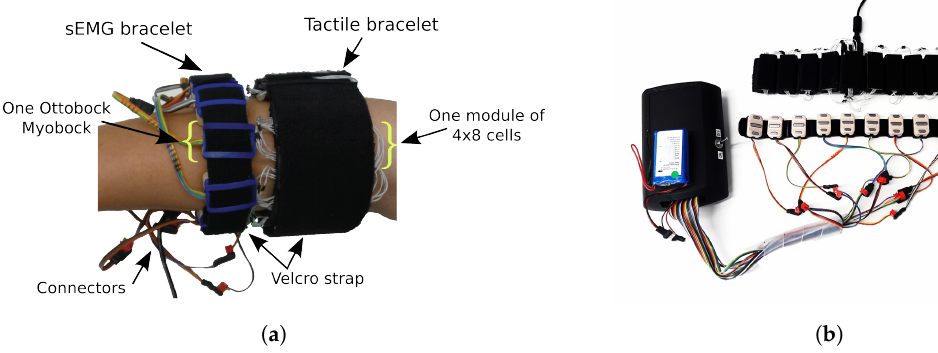
Figure 1. ( a ) A participant equipped with the two sensor devices. The proximal device is a shape-conformable tactile bracelet with 10 pressure sensor modules. The distal device is composed of 10 surface electromyography (sEMG) sensors linked to a wireless acquisition device. ( b ) The two sensor devices lain down, as shown from the side in contact with the skin. In the upper part, the tactile bracelet is linked via a mini USB cable to the computer. In the lower part, the sEMG Ottobock electrodes are linked to a data acquisition board transmitting the data via Bluetooth to the same computer. The spacing of the sensors/modules of each bracelet could be easily changed to adapt to the circumference of the forearm of each